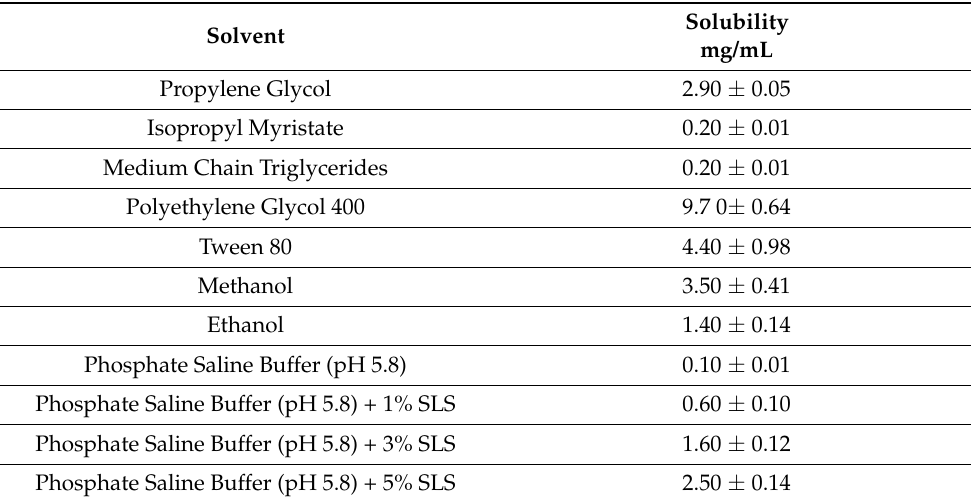
Table 3. Summary of the solubility of OXC at 48 h (mean ± S.D.) in the tested vehicles expressed as mg/mL (n = 3).